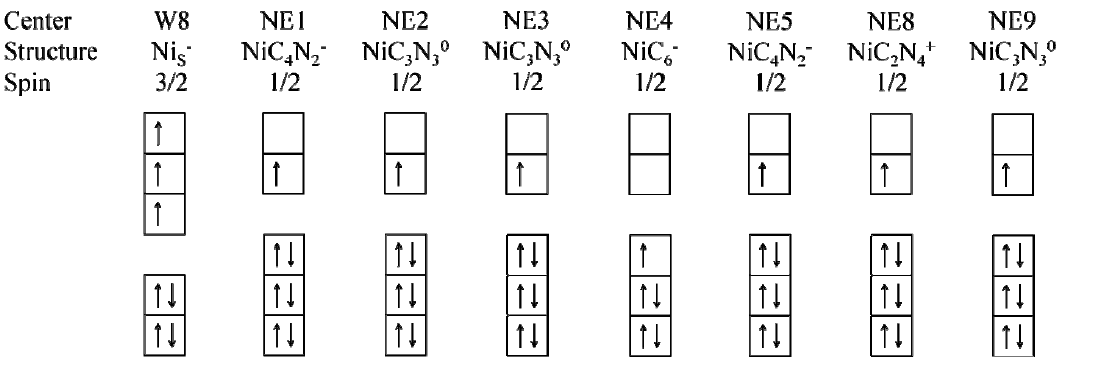
Figure 2. Electronic state of nickel-containing centers in diamond.